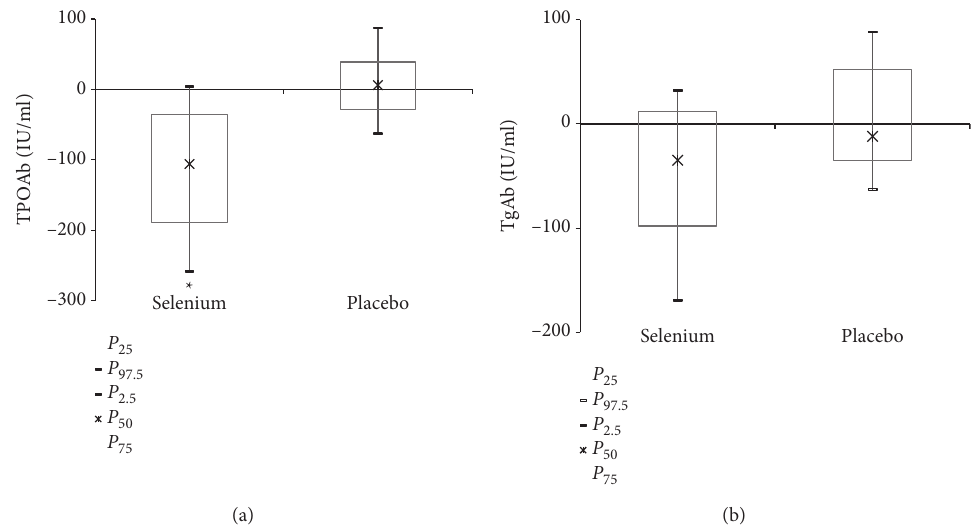
Figure 1: Comparison of the changes ( Δ ) of thyroid autoantibodies titers within the two groups. A Wilcoxon signed-rank test was used to determine the changes from post- to pretreatment (post-pre). (a) Serum TPOAb titers (IU/ml). (b) Serum TgAb titers (IU/ml). The data were shown as median ( P 25 , P 75 ). ∗ P < 0 . 05.